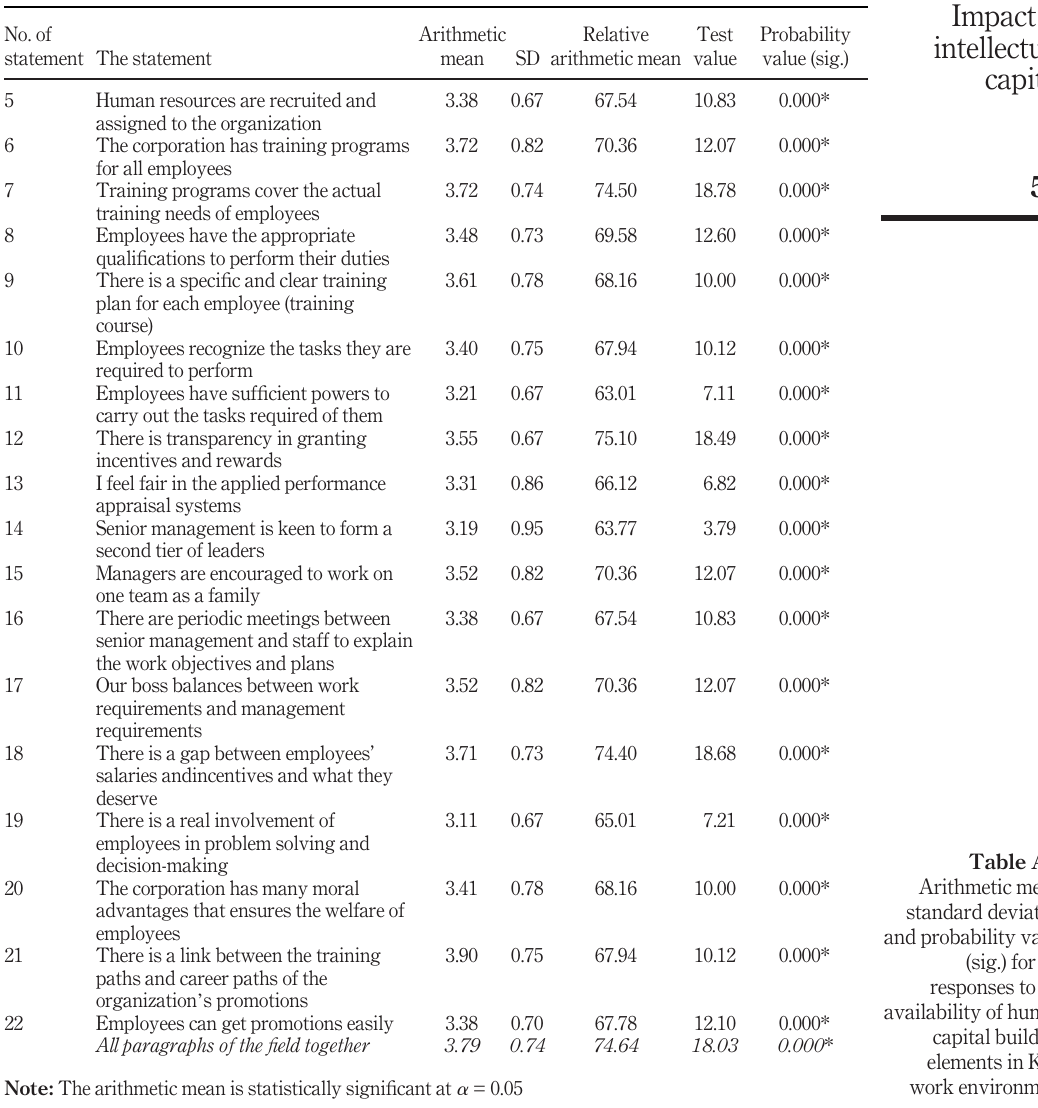
Table A3. Arithmetic mean, standard deviation and probability value (sig.) for the responses to